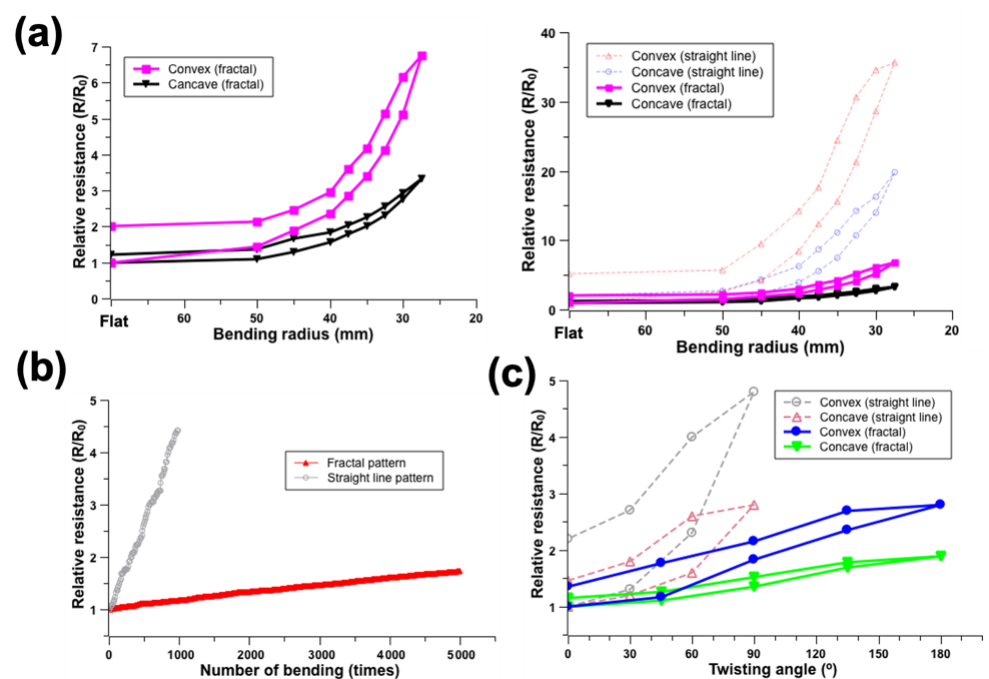
Figure 6. Mechanical and electrical performance tests of fractal patterns on PDMS. ( a ) Relative resistance change by different bending radius change ( left ) and comparison of relative resistance change between straight and fractal-shape patterns ( right ), ( b ) relative resistance change in repeated bending with a bending radius of 55 mm and comparison of relative resistance change between straight and fractal-shape pattern, and ( c ) relative resistance change and comparison of relative resistance change between straight and fractal-shape pattern by different twisting angles.